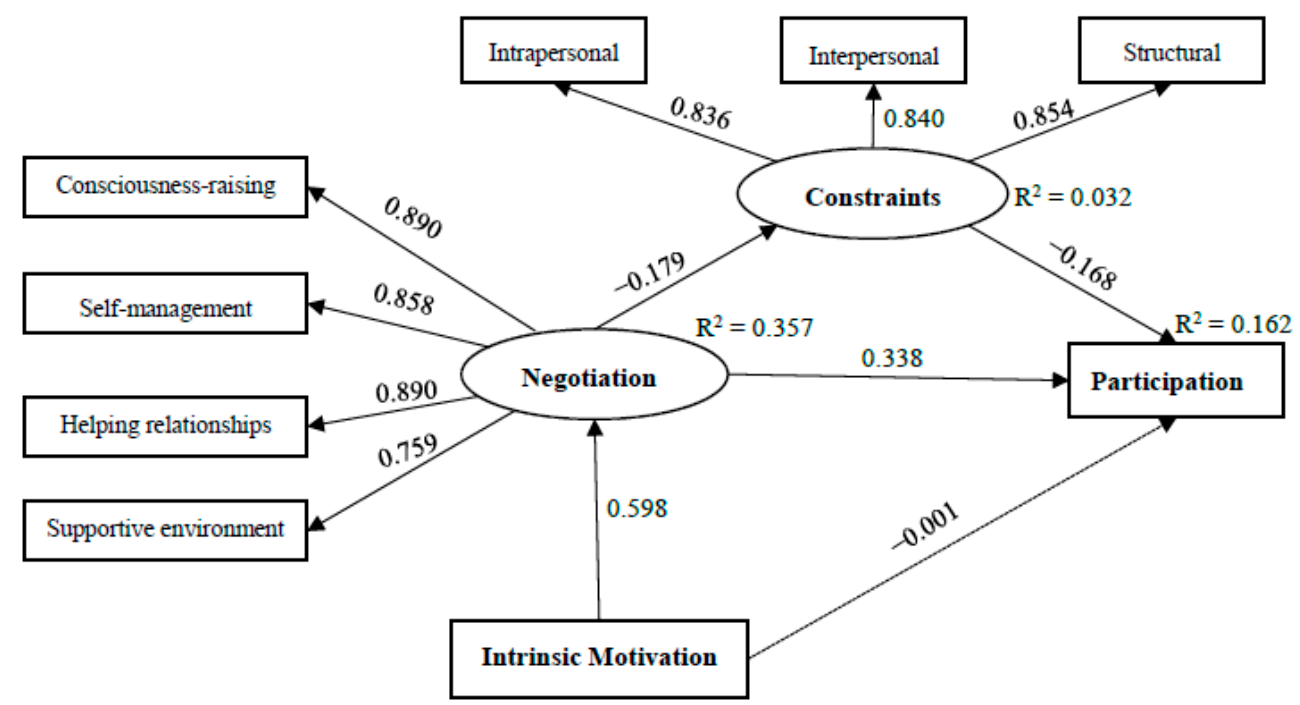
Figure 1. Structural model of the constraint negotiation process with standardized parameter esti- mates. Note: Broken line means the relationship of two variables is not significant at the 0.05 level.